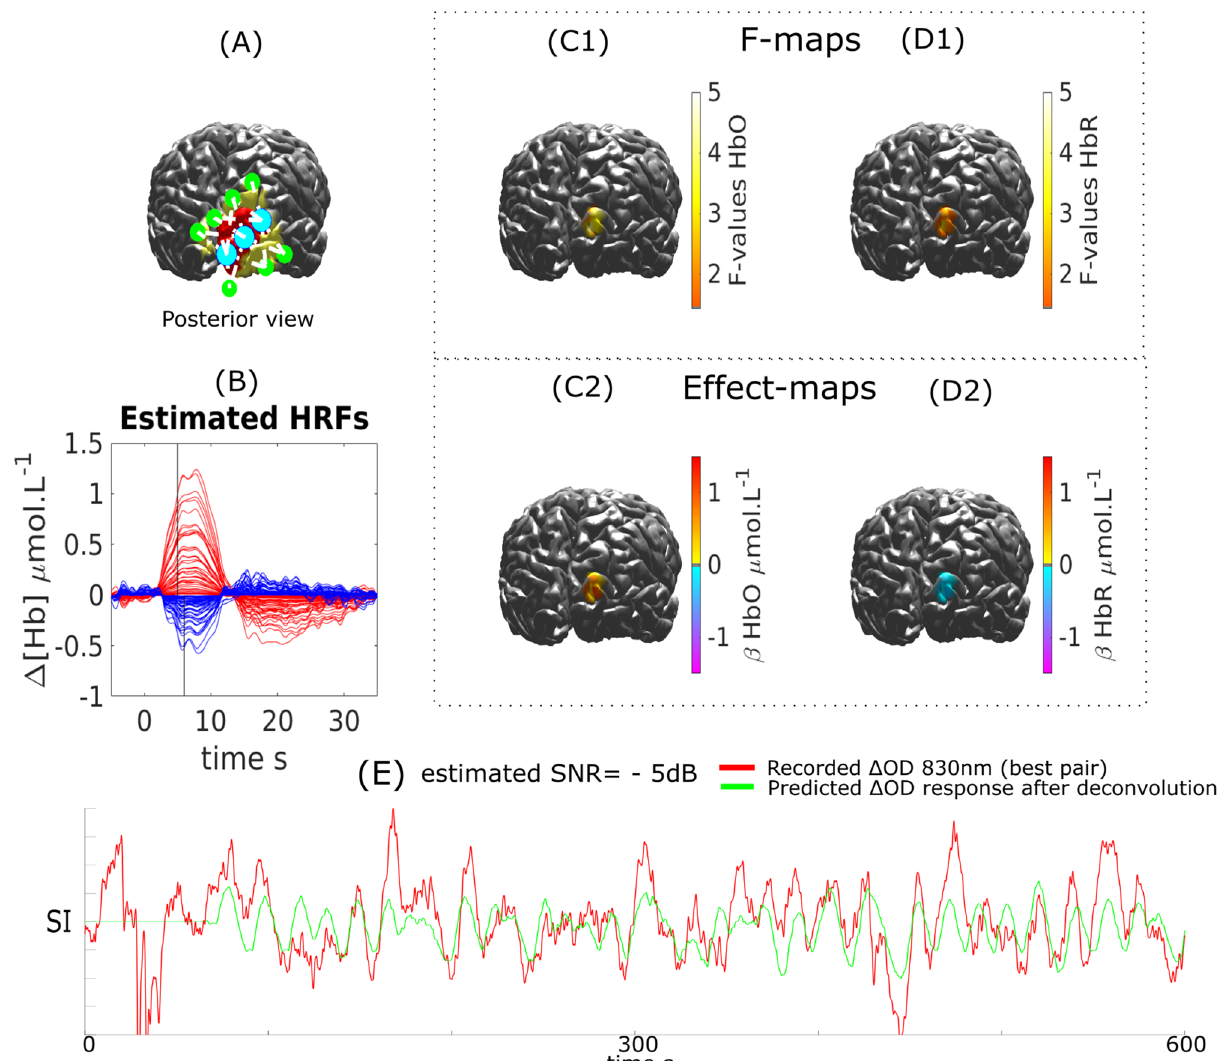
Figure 11. DOT reconstruction and HRF deconvolution for a visual task on Subject 3. ( A ) Montage, ROI (red) and FOV (yellow). ( B ) Estimated HRF time courses. ( C1 , C2 ) (cid:31) [ HbO ] : Thresholded F-map ( α = 0.05 , Bonferronni corrected) and associated effect size map estimated at TTP 1 = 5 s. ( D1 , D2 ) (cid:31) [ HbR ] : Thresholded F-map ( α = 0.05 , Bonferronni corrected) and associated effect size map estimated at TTP 1 = 6 s. ( E ) Most 830 sensitive (cid:31) OD pair over the target ROI and corresponding predicted response after deconvolution (at the sensor level) with the binary stimuli